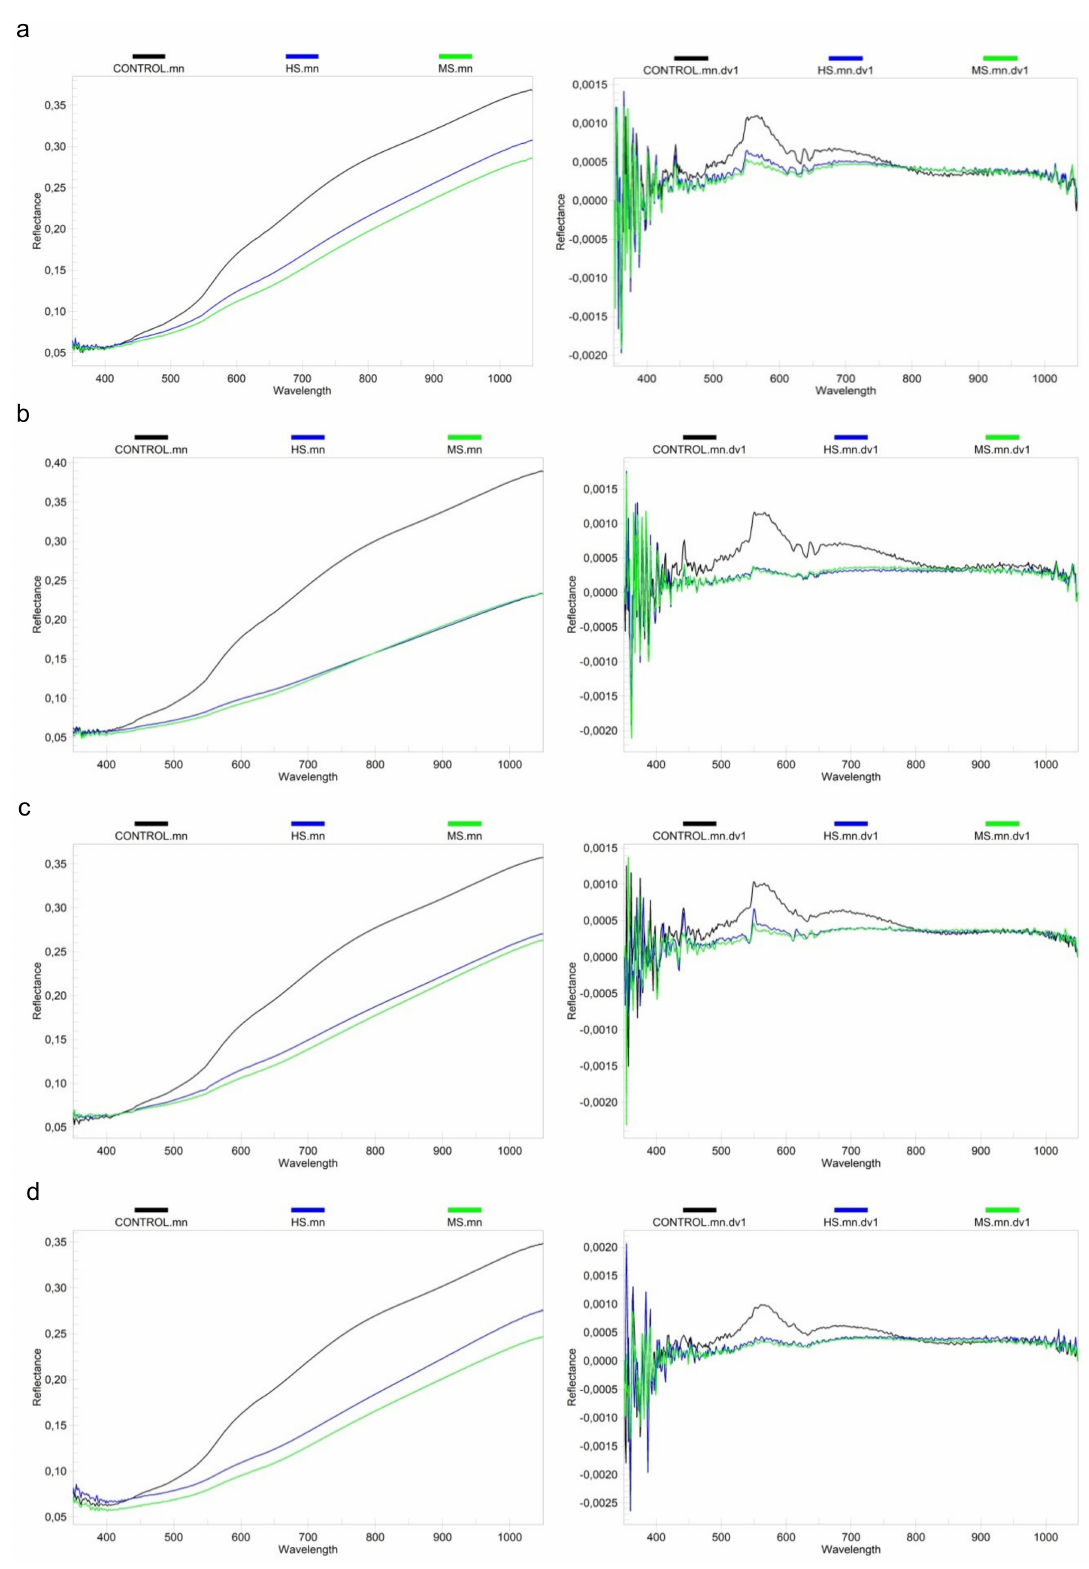
Figure A1. Difference in mean soil reflectance (left) and average first derivative of soil reflectance (right) according to treatments and sampling time: ( a ) 5 days, ( b ) 3 months, ( c ) 6 months, and ( d ) 12 months after the